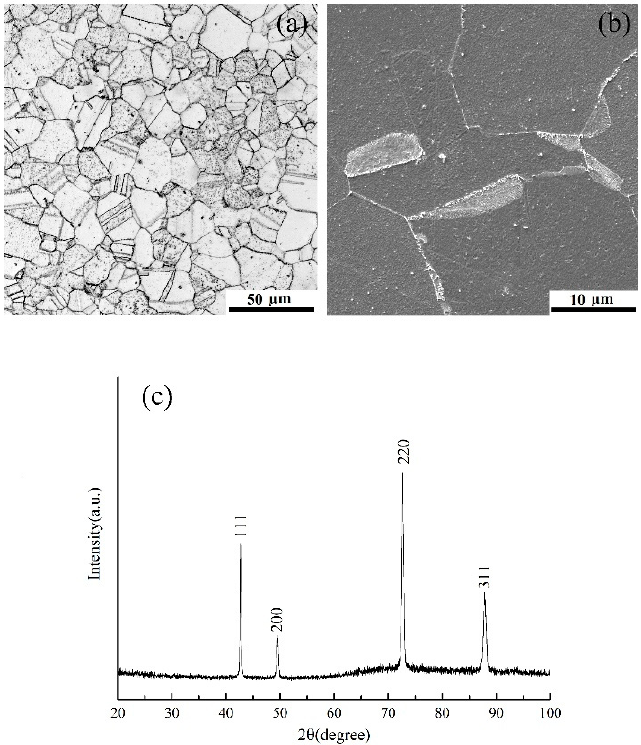
Figure 2. ( a ) OM, ( b ) SEI, and ( c ) XRD of the HEA after quenching, from 1323 K, and isothermal holding at 873 K, for 24 h.